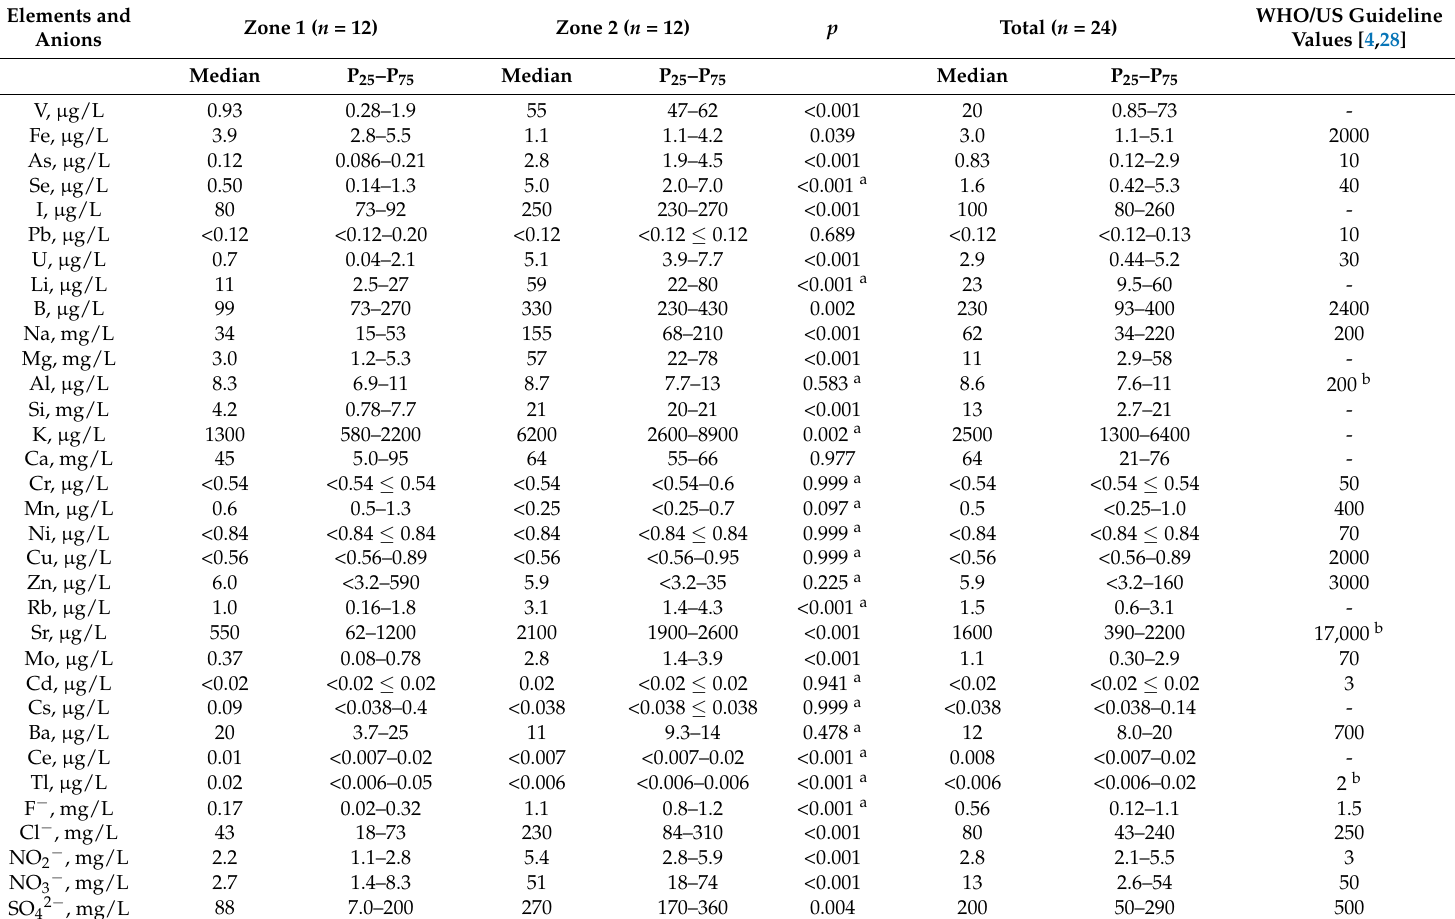
Table 3. Concentration of elements and anions in distributed drinking water from zones 1 and 2 in the Sahara refugee camps and comparison with guideline values from WHO or